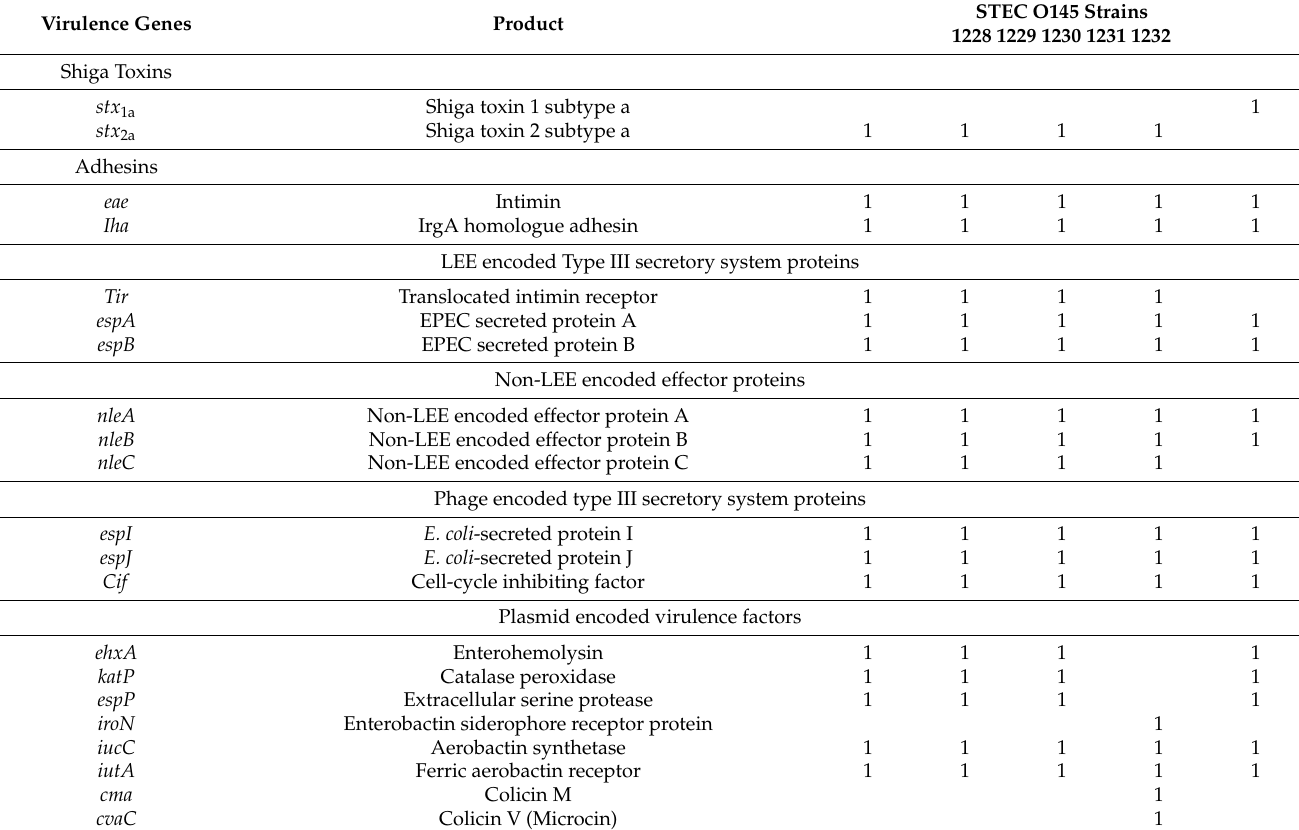
Table 3. Distribution of virulence and resistance genes in STEC O145